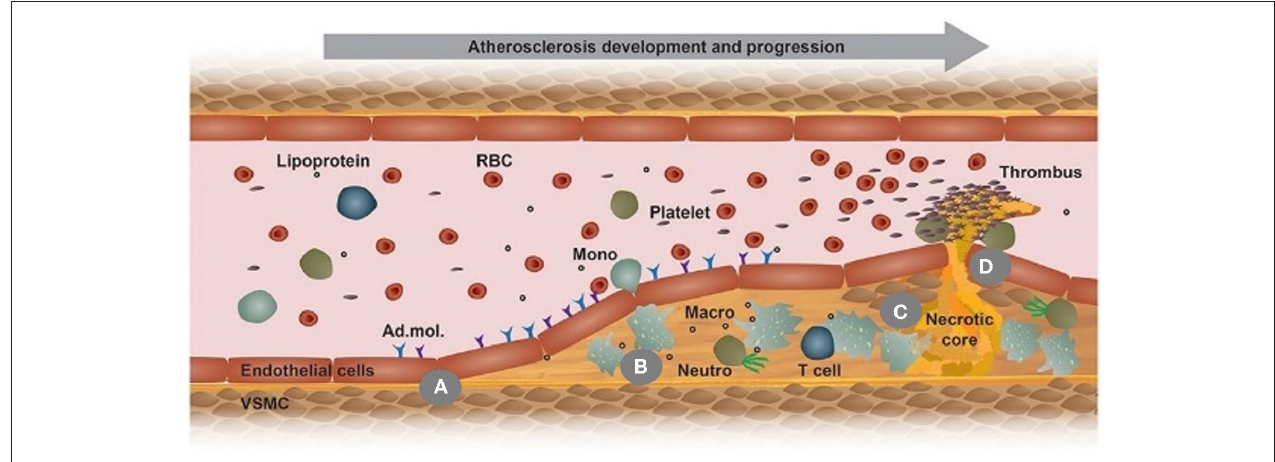
FIGURE 2 | This scheme illustrates the development of an atherosclerotic plaque from left to right in a longitudinal section of an arterial vessel: (A) Upon activation by metabolic or inflammatory triggers, endothelial cells express adhesion molecules (Ad. mol.) that promote the recruitment of monocytes (Mono); (B) Monocyte differentiate into macrophages (Macro) and uptake Ox-LDL, leading to foam cell formation; (C) Macrophage (Macro) and foam cells eventually die and fall apart, thereby forming a necrotic core; (D) Advanced, vulnerable plaques can rupture and thereby form an arterial thrombus. Adapted, with permission, from ( 23) (A–D) .